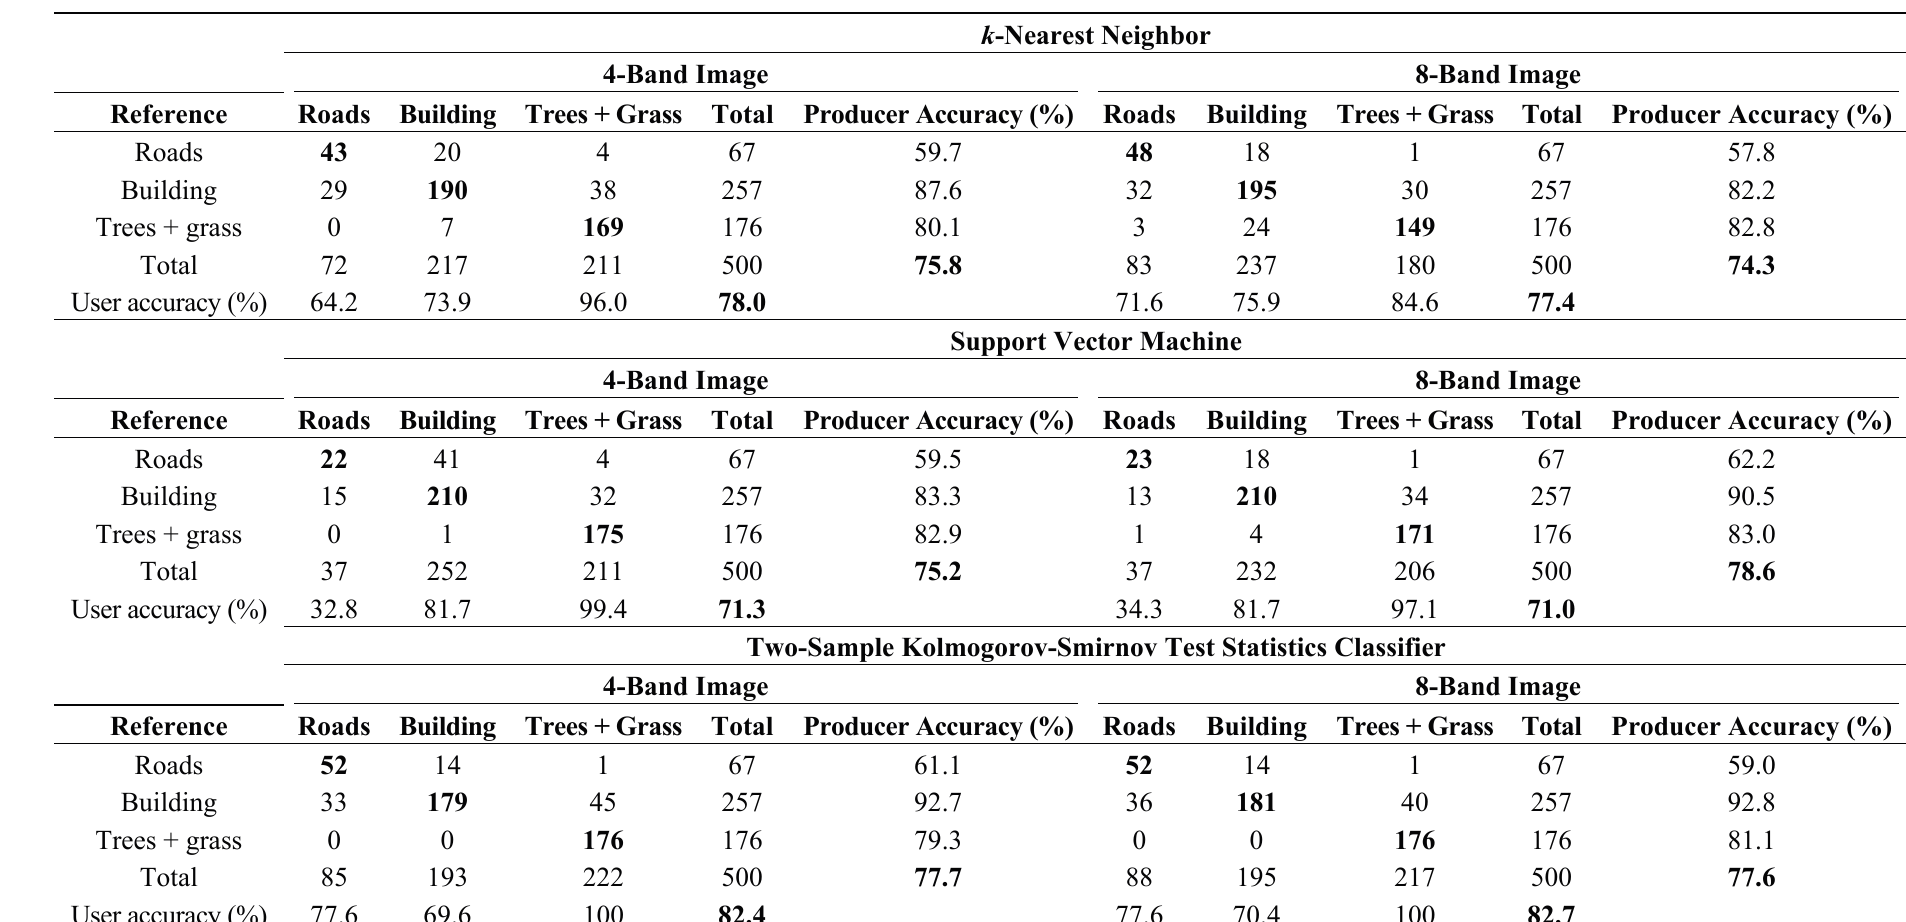
Table 3. A confusion matrix for all four classifiers for the 4- and 8-band input image in the event when k -NN and SVM classification methods were conducted with four spectral attributes. The user and producer accuracy values in bold represent the mean overall user and producer